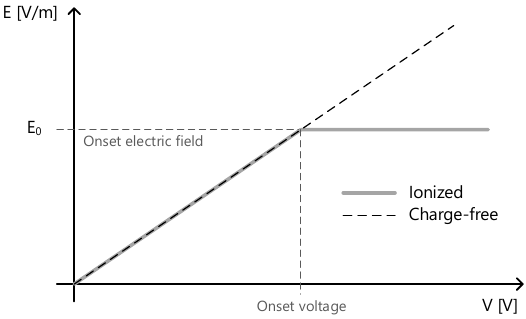
Figure 3. Overview of the electric field strength versus applied electric voltage at the discharging electrode.